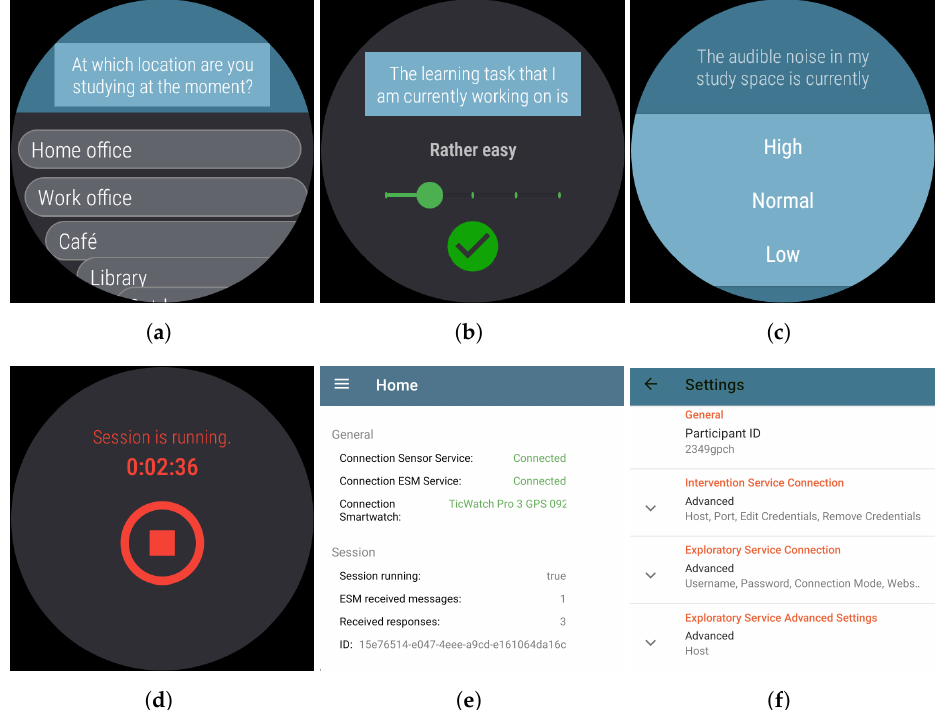
Figure 6. Figures ( a – c ) show different display and input formats for questions on the smartwatch: ( a ) a vertically scrollable list of answers allows to offer a wider range of options; ( b ) a horizontal slider enables participants to give their ratings on a scale; and ( c ) one click on an answer option in a micro questionnaire and it vanishes. The session duration is displayed in the interface shown in figure ( d ) when the session is running and no response is requested. Figures ( e , f ) show part of the smartphone interface: ( e ) this overview helps participants to see the status of the application; and ( f ) in the settings they can set up the server connection and